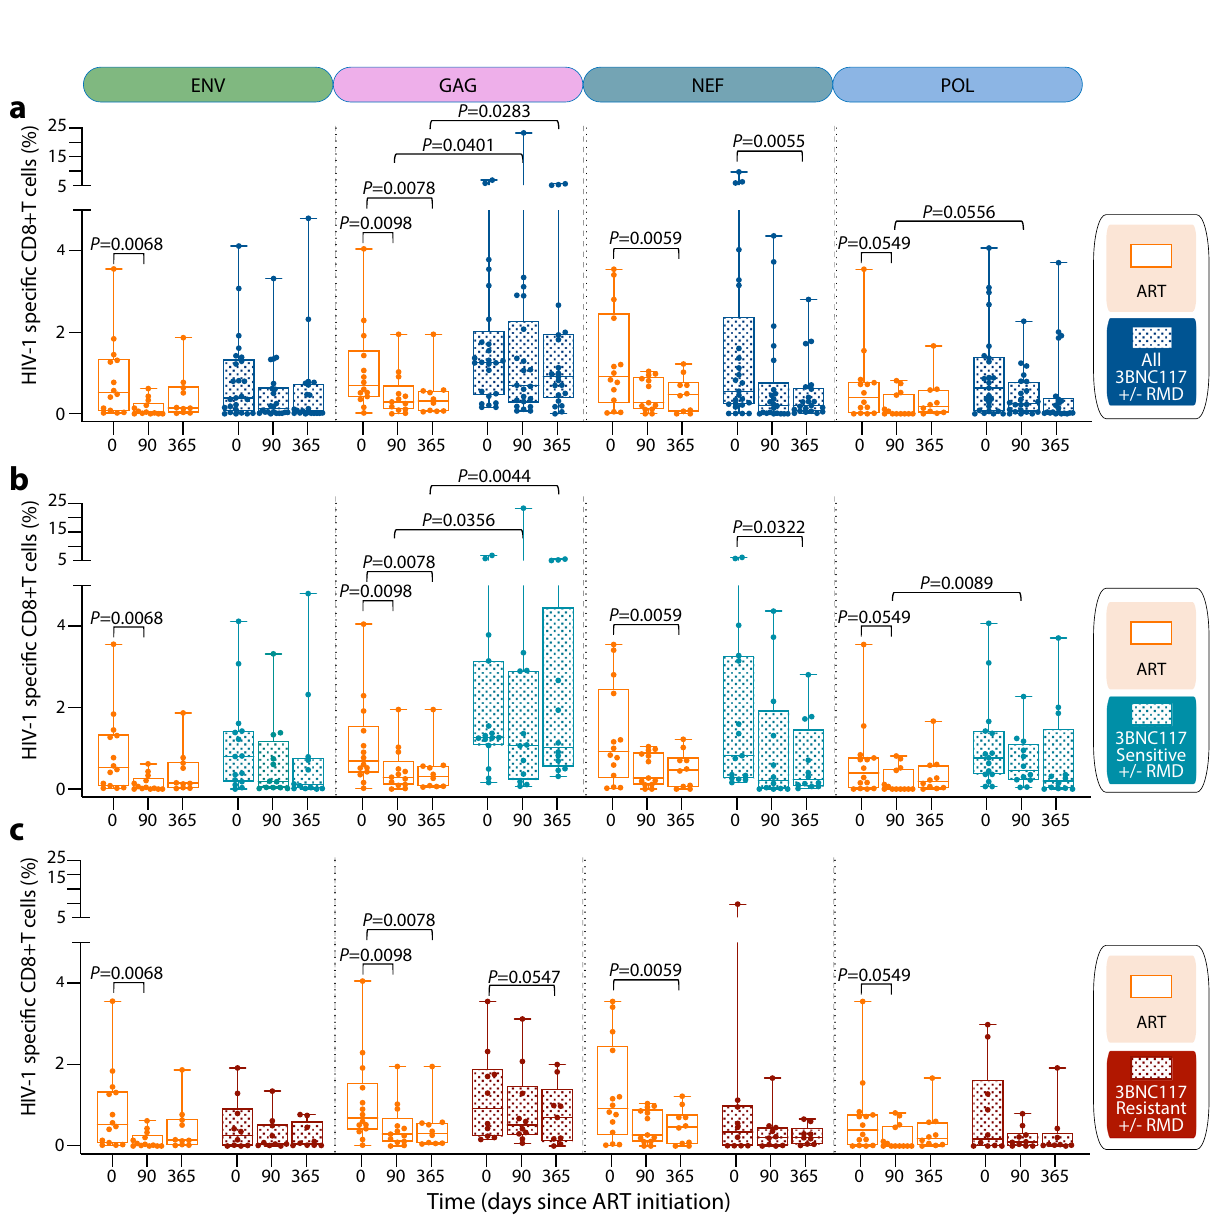
Fig. 1 | Evaluation of total HIV-speci fi c T cell responses by AIM assay. a Study design and samples evaluated. b Representation of the activation-induced marker (AIM)protocolused. c GatingstrategyusedtodetectCD4 + andCD8 + TAIM + Tcells which were de fi ned as the addition of the frequency of cells that were either CD69 + PD-L1 + 4-1BB + , CD69 + PD-L1 + , CD69 + 4-1BB + or PD-L1 + 4-1BB + after subtracting the frequency of the non-stimulated condition from the antigen stimulated con- ditions. Total HIV-speci fi c AIM + cells was calculated as sum of each of the four independentantigenstimulations.TotalHIV-1speci fi cCD4 + ( d )andCD8 + Tcells( e ) andStaphylococcalEnterotoxinB(SEB)-responsiveCD4 + ( f )andCD8 + Tcells( g )at